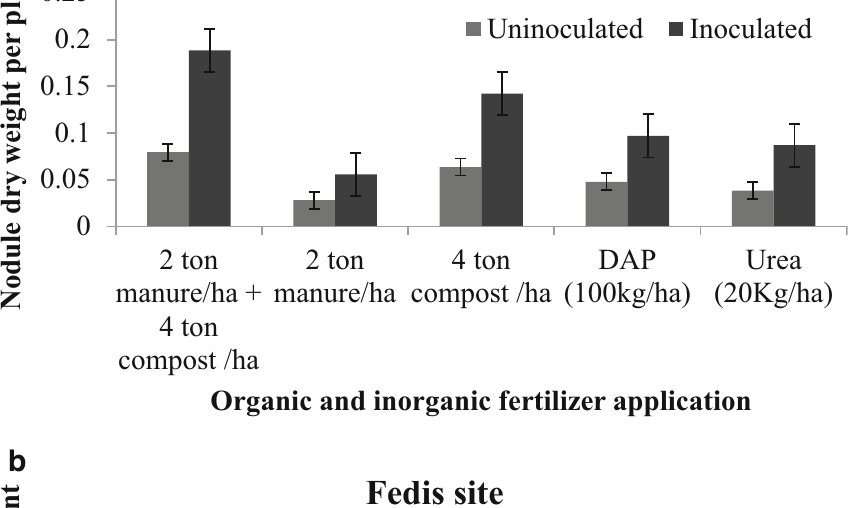
Fig. 2 Effect of Bradyrhizobium inoculation on nodule dry weight of peanut at a Babillae and b Fedis